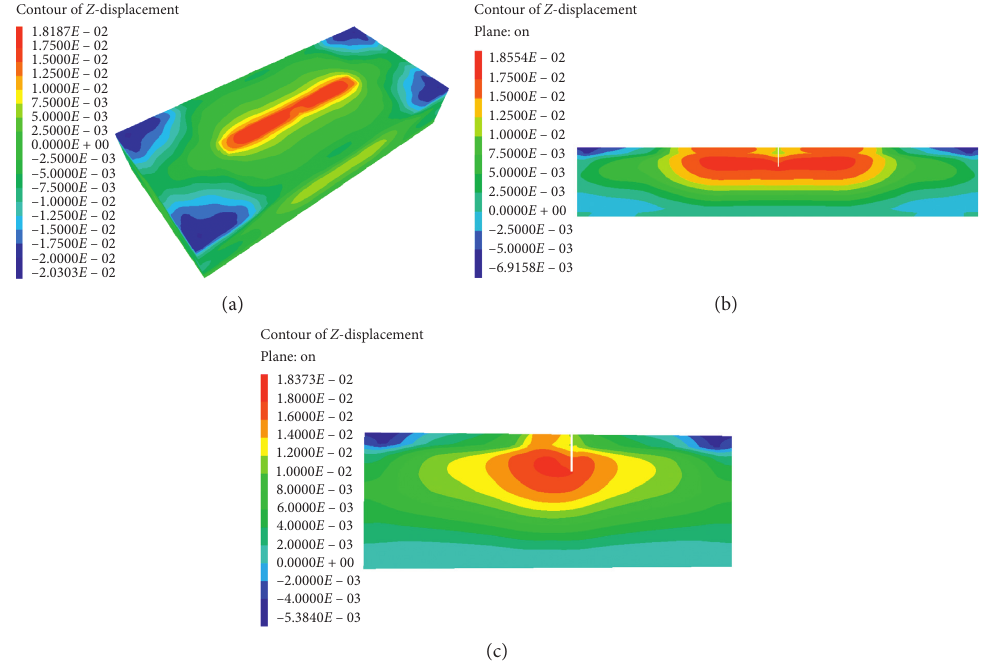
Figure 18: Single well subsidence nephogram after the second drawdown (unit: m). (a) Three-dimensional diagram. (b) Cross section of the well midpoint. (c) Longitudinal section of the well midpoint.